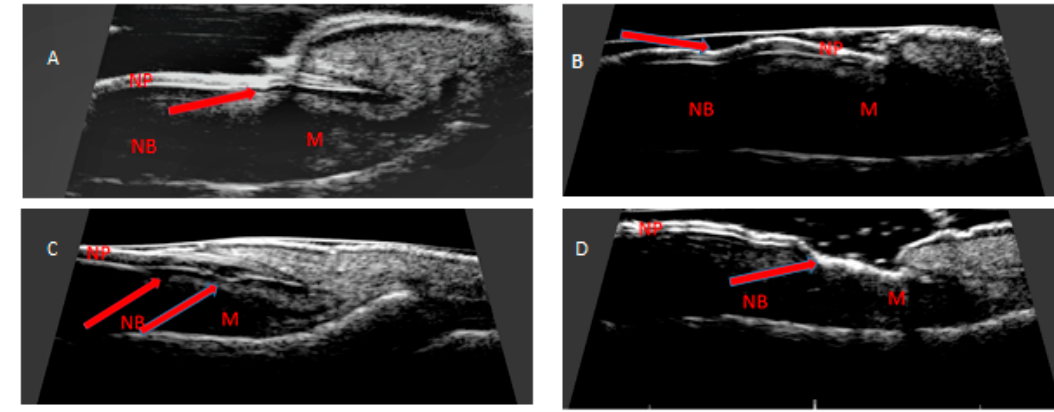
Figure 1. Longitudinal scan of psoriatic nails. ( A ) Focal hyperechoic involvement of the dorsal plate (arrow). ( B ) Loosening of the borders of the ventral plate (arrow). ( C ) Wavy plates (arrows). ( D ) Loss of definition of both plates (arrow). NP: nail plate; NB: nail bed; M: nail matrix.